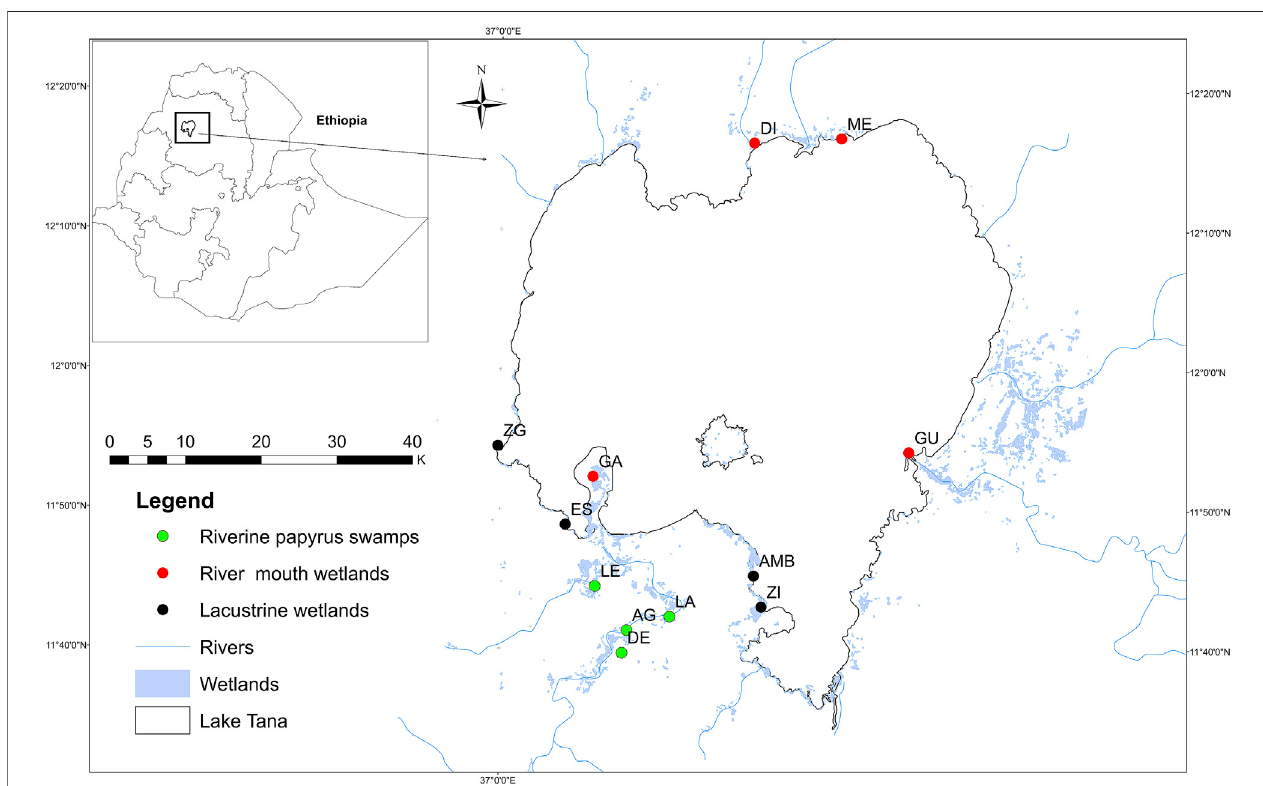
FIGURE 1 | Map of Lake Tana and its wetlands; dots show the investigated wetlands divided into the different wetland types (for individual wetland code; see Supplementary Table S1 .